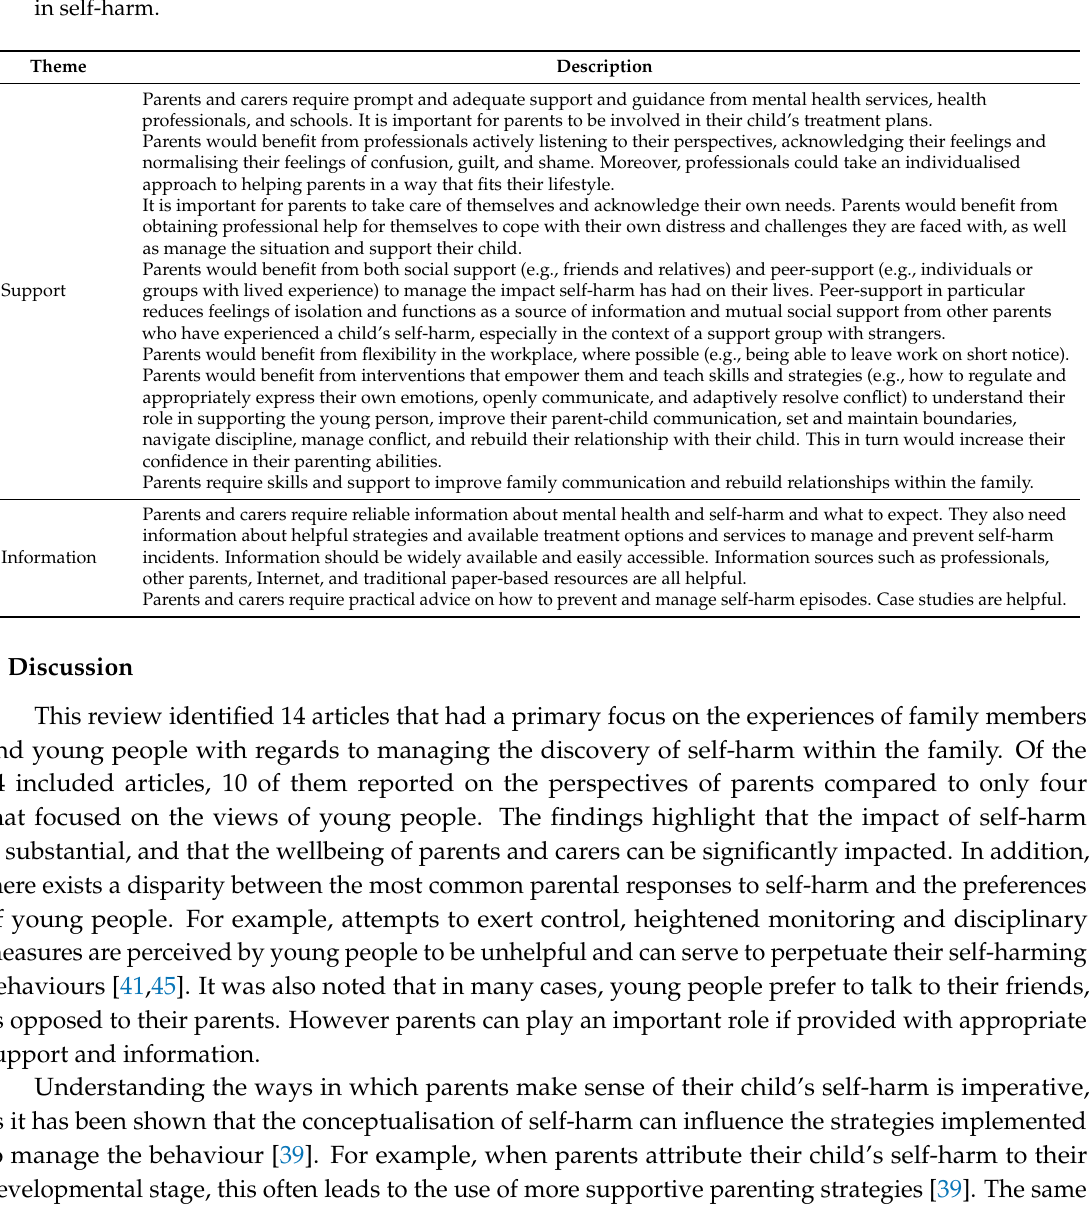
Table 4. What parents and carers need to help themselves and the young people whom have engaged in